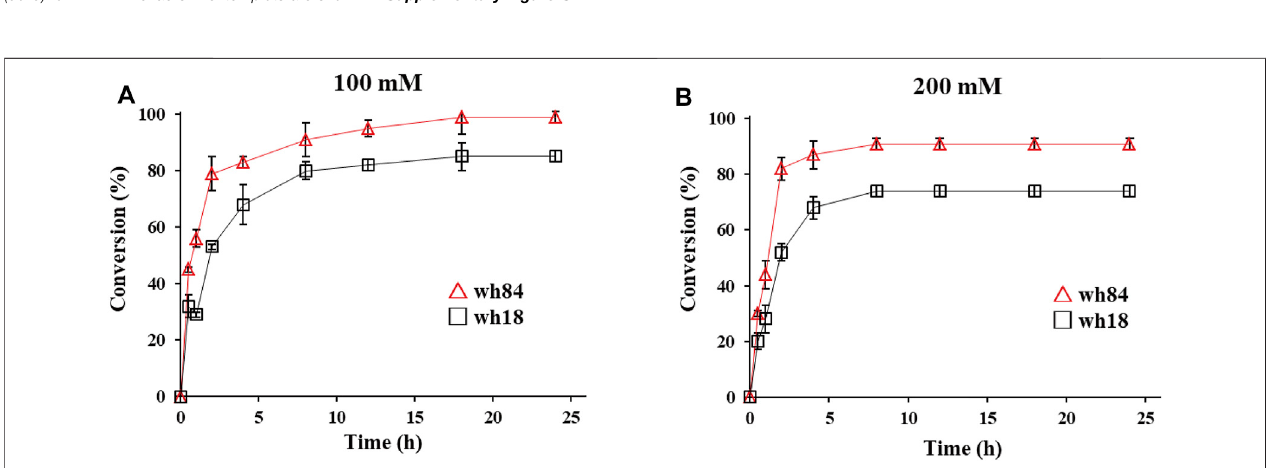
FIGURE 4 | Preparative-scale of the asymmetric amination reactions of substrate 1a 100 mM (A) and 200 mM (B) catalyzed by wh18 and wh84 ( □ : wh18, △ : wh84).Reactionsystem:0.1 g/mlwetcell,1